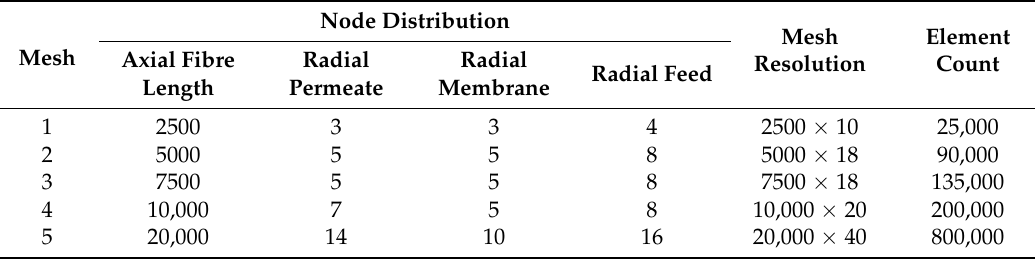
Table 1. Node distribution of each Grid Independence Test (GIT) test case.